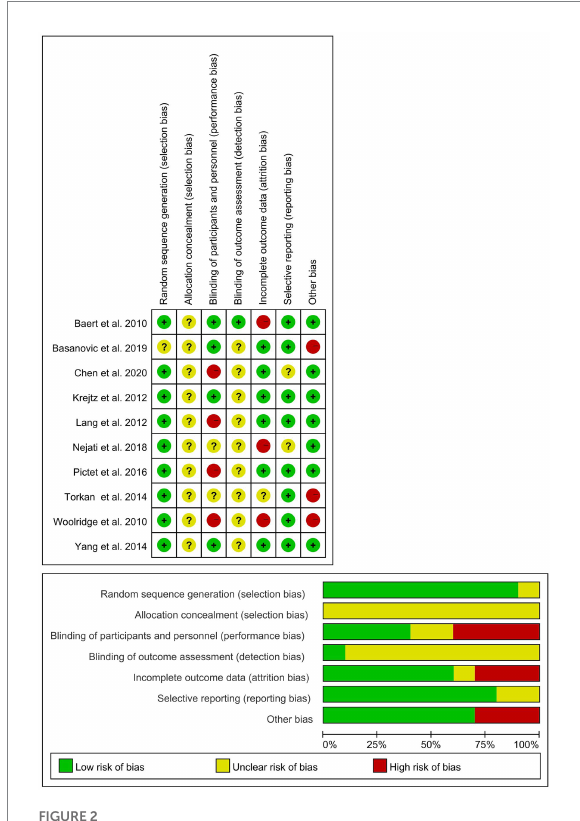
FIGURE 2 Risk of bias graph. Review authors’ judgments about each risk of bias item presented as percentages across all included